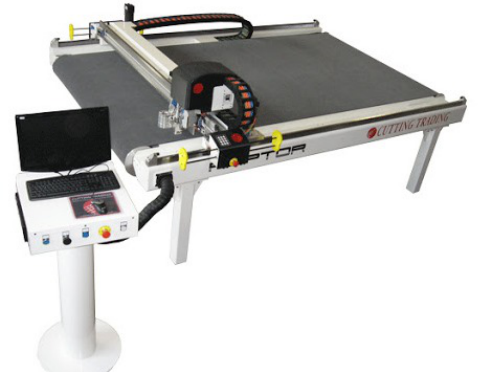
Figure 1. The machine RAPTOR-HI-2.5 built by Cutting Trading International.